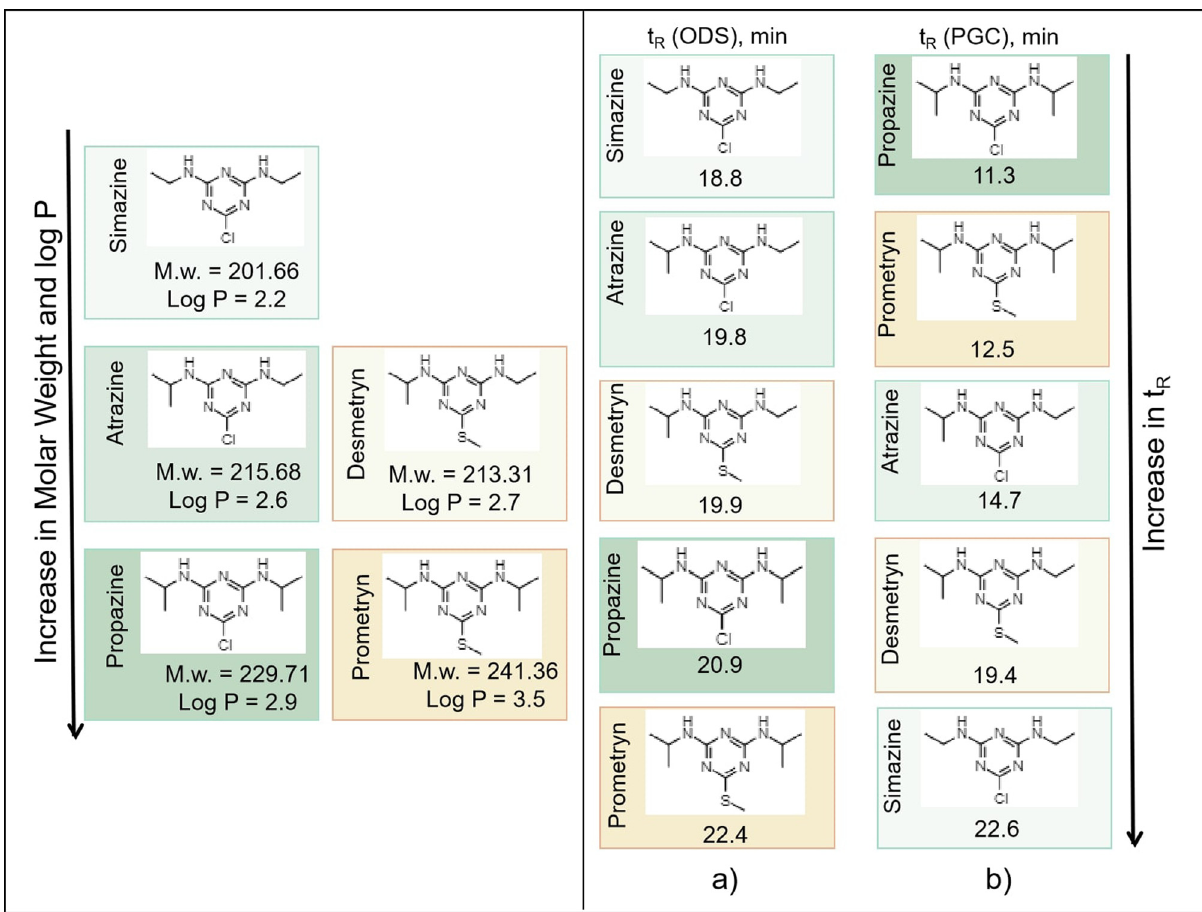
Figure 3: On the left side: values of molar weight ( M w ) and log P of triazine herbicides. On the right side: retention times ( t R ) of herbicides on ODS ( a ) and PGC ( b )